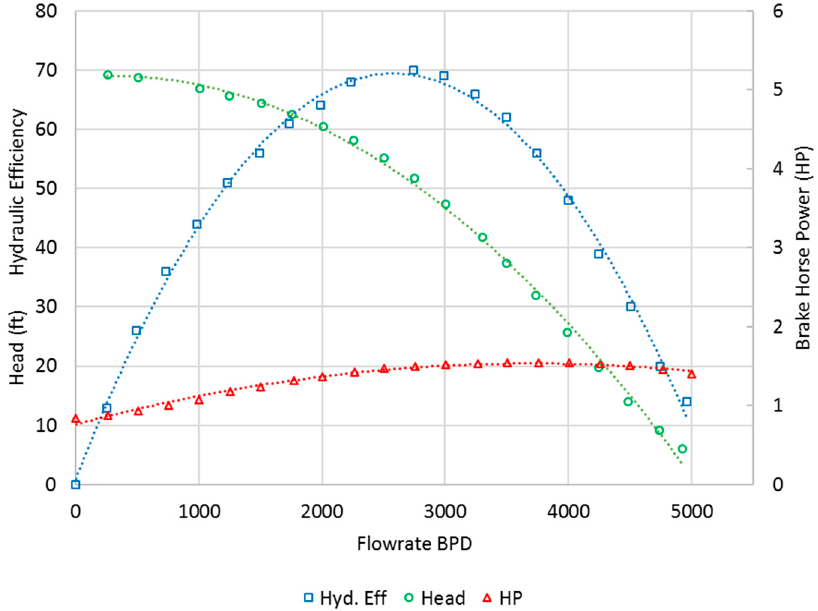
Figure 4. Example pump curves–1 stage at 60 HZ.